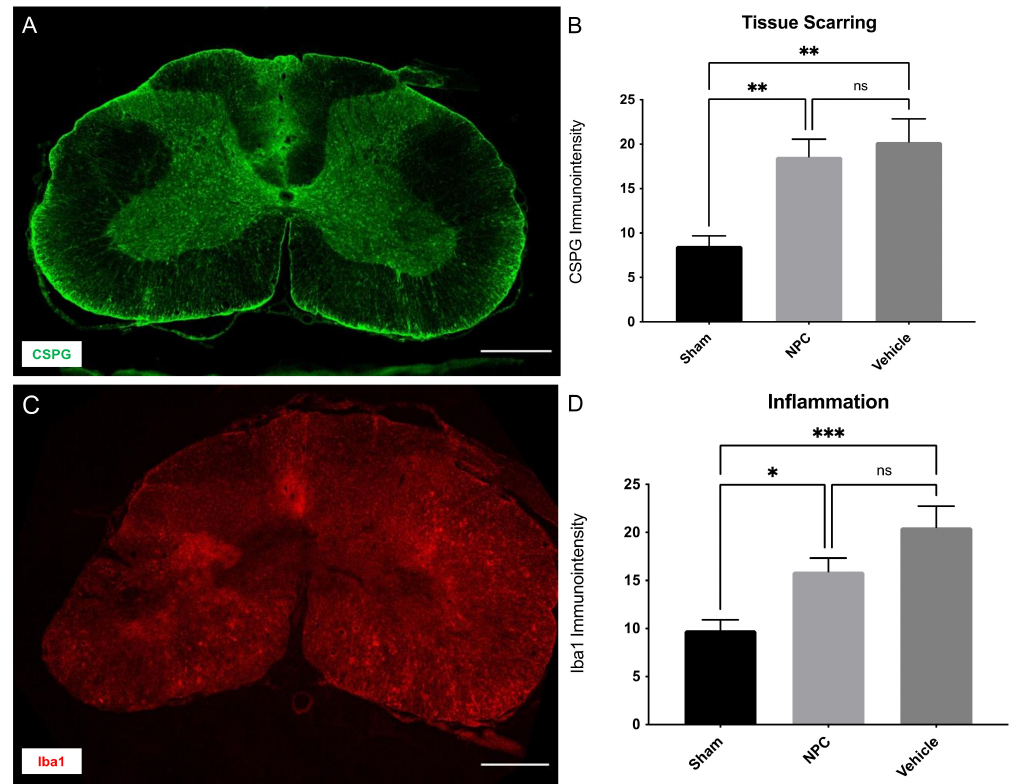
Figure 5. Tissue scarring and inflammation in the injured spinal cord eight weeks after severe cervical SCI. ( A ) Spinal cord cross-section of an NPC animal stained for CSPG, a marker for proteoglycans in the extracellular matrix at 10 × magnification (scale bar = 500 µ m). ( B ) The immuno-intensity of the CSPG-staining and thus the extent of tissue scarring showed no significant difference between NPC animals (group 1) and Vehicle animals (group 2; n = 8 animals per group; one-way ANOVA with Tukey-HSD-test; p = 0.8281). ( C ) Spinal cord cross-section of a Vehicle animal stained for Iba1, a marker for macrophages at 10 × magnification (scale bar = 500 µ m). ( D ) The immuno-intensity of the Iba1-staining and thus the number of Iba1 + macrophages was not significantly reduced in NPC animals compared to Vehicle animals ( n = 8 animals per group; one-way ANOVA with Tukey-HSD-test; p = 0.1468) (* p < 0.05; ** p < 0.01; *** p < 0.001 and ns = not